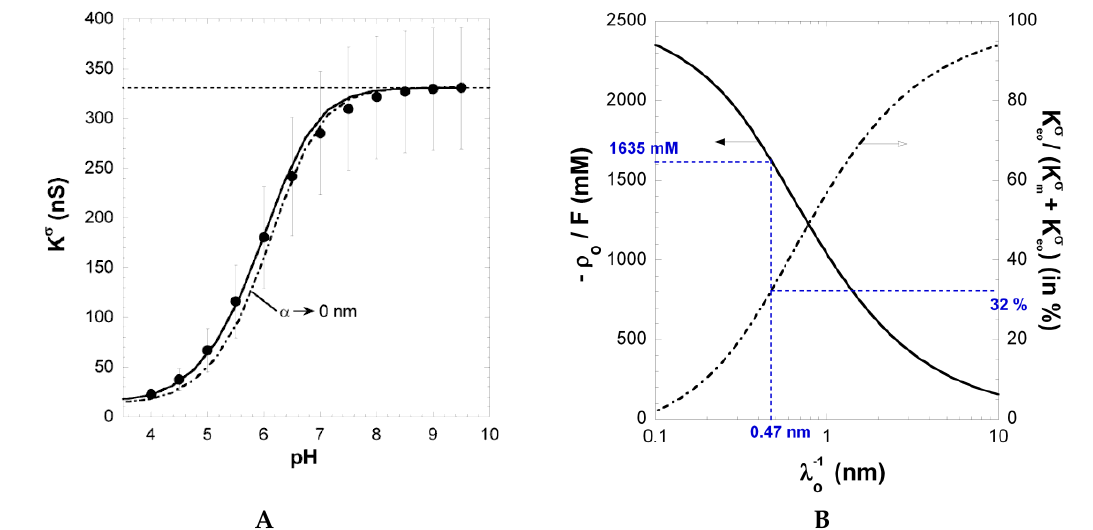
A B Figure 4. ( A ) Surface conductivity K σ vs. pH for PAA film in 1 mM KCl solution (symbols). The solid line represents the reconstruction of the data by theory. Parameters: ρ o { F “ -1635 mM, 1 { λ o “ 0.47 nm, p K 1 “ 3.3, and α = 27 nm (solid line) as well as α Ñ 0 (dotted line). The plateau value reached by K σ at large pH (horizontal dashed line) was used as a basis for the determination of ( λ o ; ρ o ). ( B ) Set of ( λ o ; ρ o ) couples that best reproduce the experimentally determined surface conductivity K σ at large pH. The contribution of electroosmosis to the total surface conductivity is given in terms of the ratio K σ eo {p K σ m ` K σ eo q on the right axis. The ( λ o ; ρ o ) couple consistent with K σ and I str { ∆ P data is highlighted in blue. See the text and [26] for further details. Reprinted from [26]. Copyright 2011 with permission from